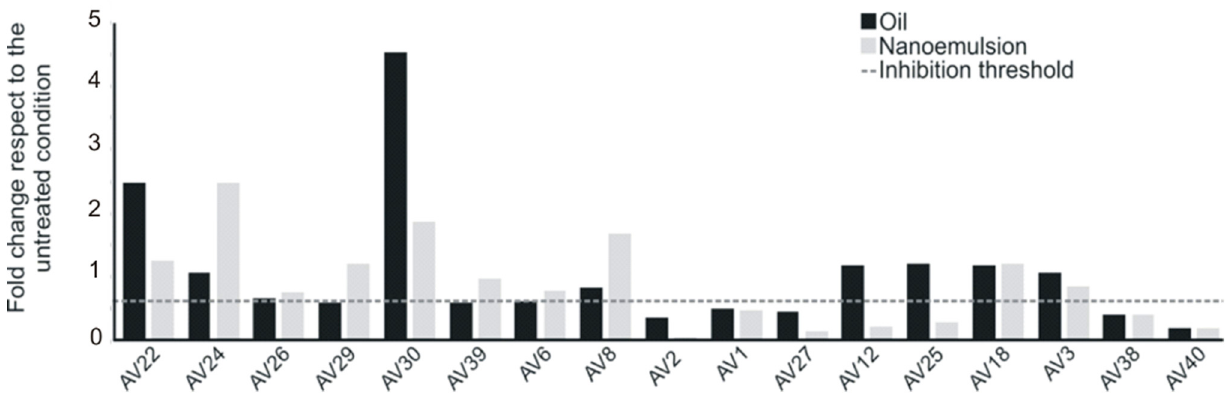
Figure 6. Biofilm inhibition with SEO and NEs in sub-MIC concentrations, measured through crystal violet staining.